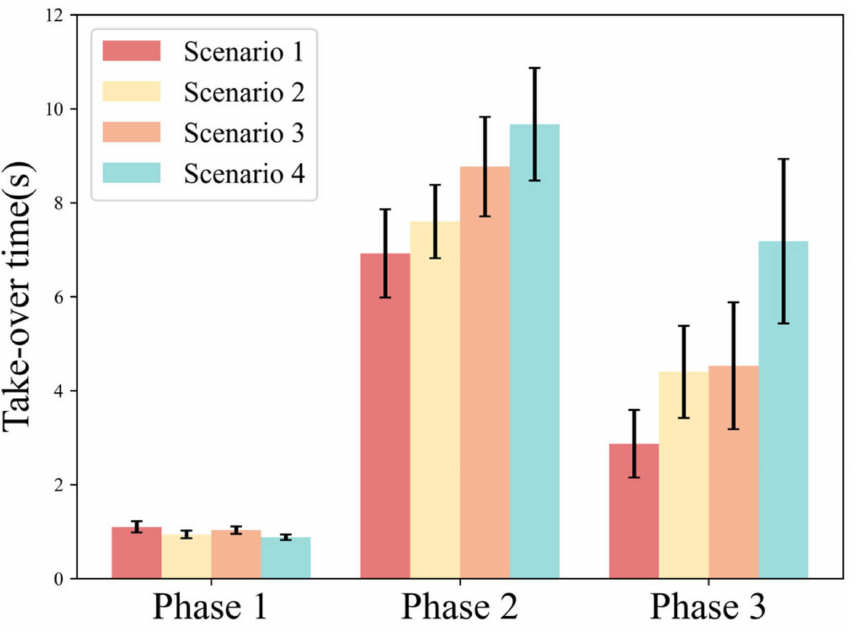
Figure 9. Variation pattern of take-over